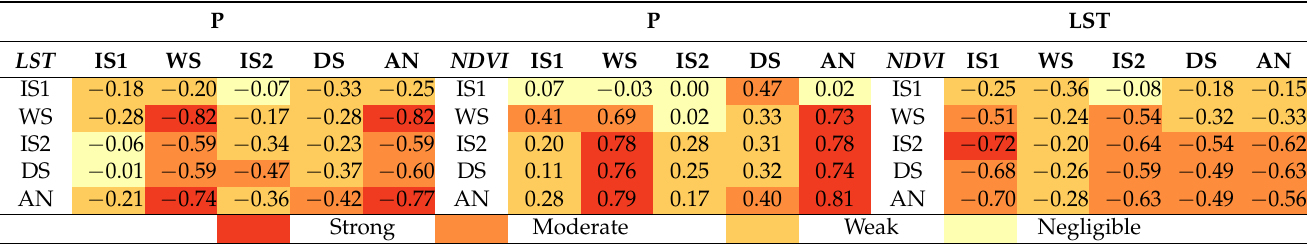
Table 3. Seasonal Pearson’s correlation coefficients between the Land Surface Temperature (LST), the Normalized Difference Vegetation Index (NDVI), and Precipitation (P) in the Guadalupe Valley Basin, Baja California,